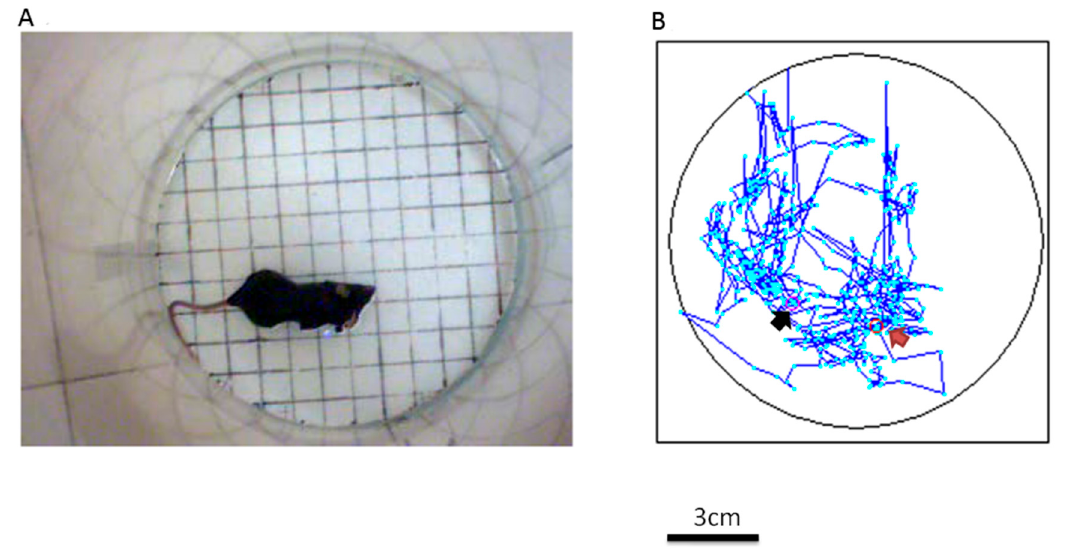
Figure 4. Auto-tracking device for testing motor functions in an electromagnetic field test. ( A ) The animal is placed in the electromagnetic field, and an auto-tracking device measures locomotive activity via programming to catch the blue light on the head of the mouse in the electromagnetic resonance field. ( B ) The traveled path is drawn with a blue line in the electromagnetic field. The black arrow represents the starting point and the red arrow represents the ending point.